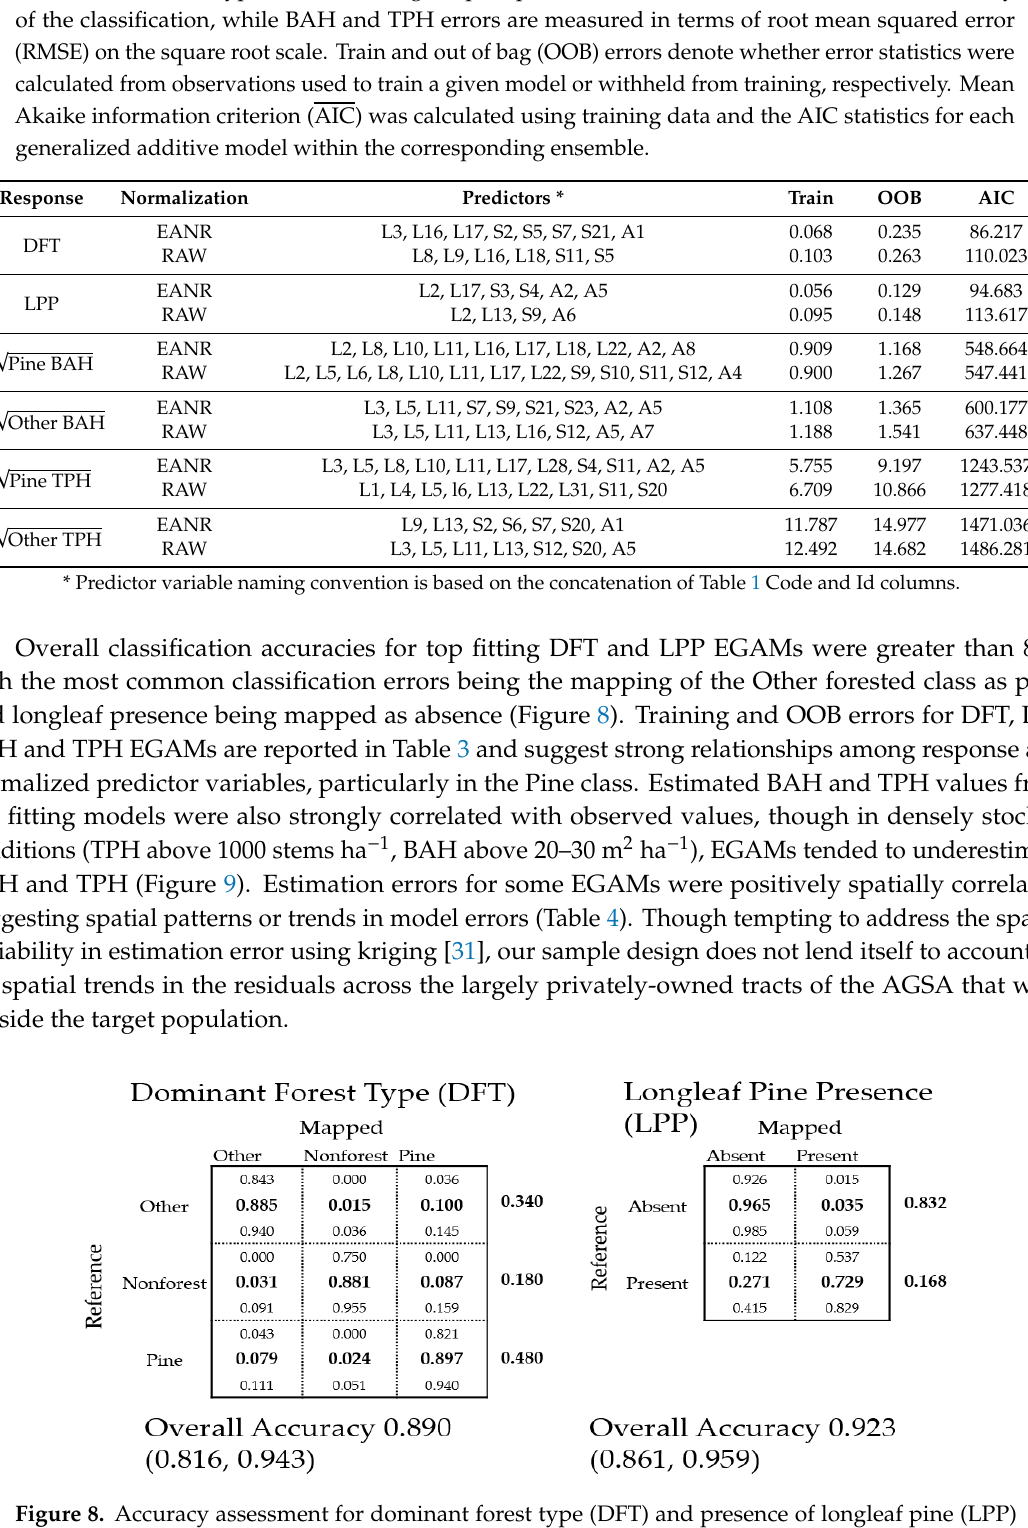
Table 3. Selected predictor variables and mean error statistics for normalized (EANR) and non-normalized (RAW) based ensemble generalized additive models (EGAMs). Error statistics for dominant forest type (DFT) and longleaf pine presence (LPP) models are in terms of 1–accuracy of the classification, while BAH and TPH errors are measured in terms of root mean squared error (RMSE) on the square root scale. Train and out of bag (OOB) errors denote whether error statistics were calculated from observations used to train a given model or withheld from training, respectively. Mean Akaike information criterion (AIC) was calculated using training data and the AIC statistics for each generalized additive model within the corresponding ensemble.